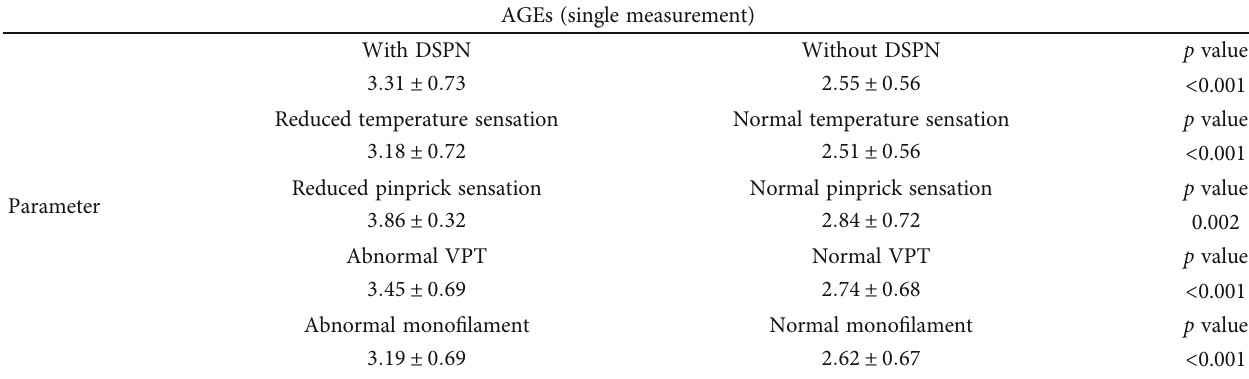
Table 1: AGEs (single measurement) and parameters of DSPN.